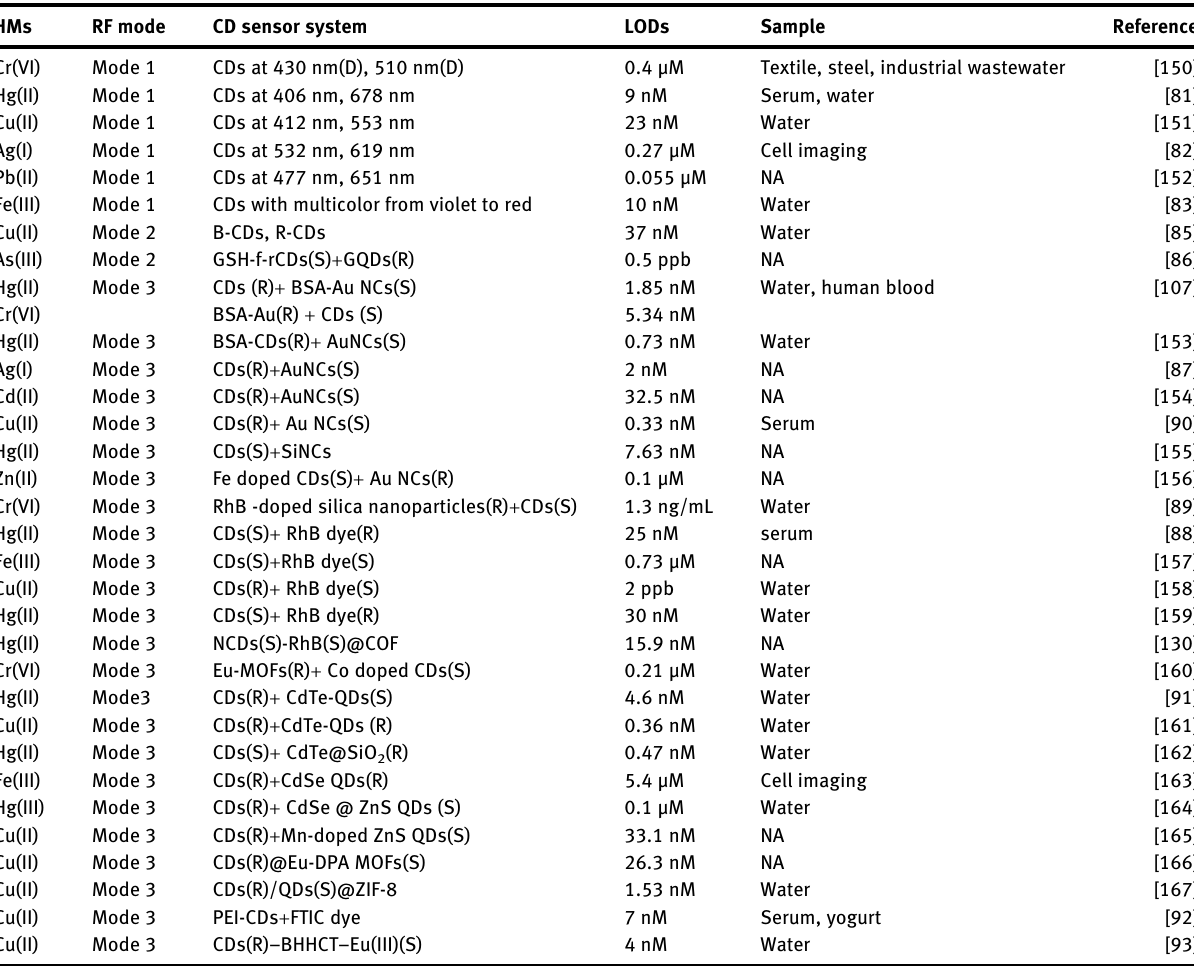
Table  : Summary of RF CD-based sensors for HMs